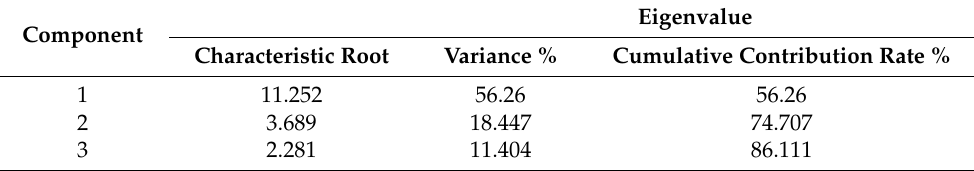
Table 2. Interpretation of total variance.